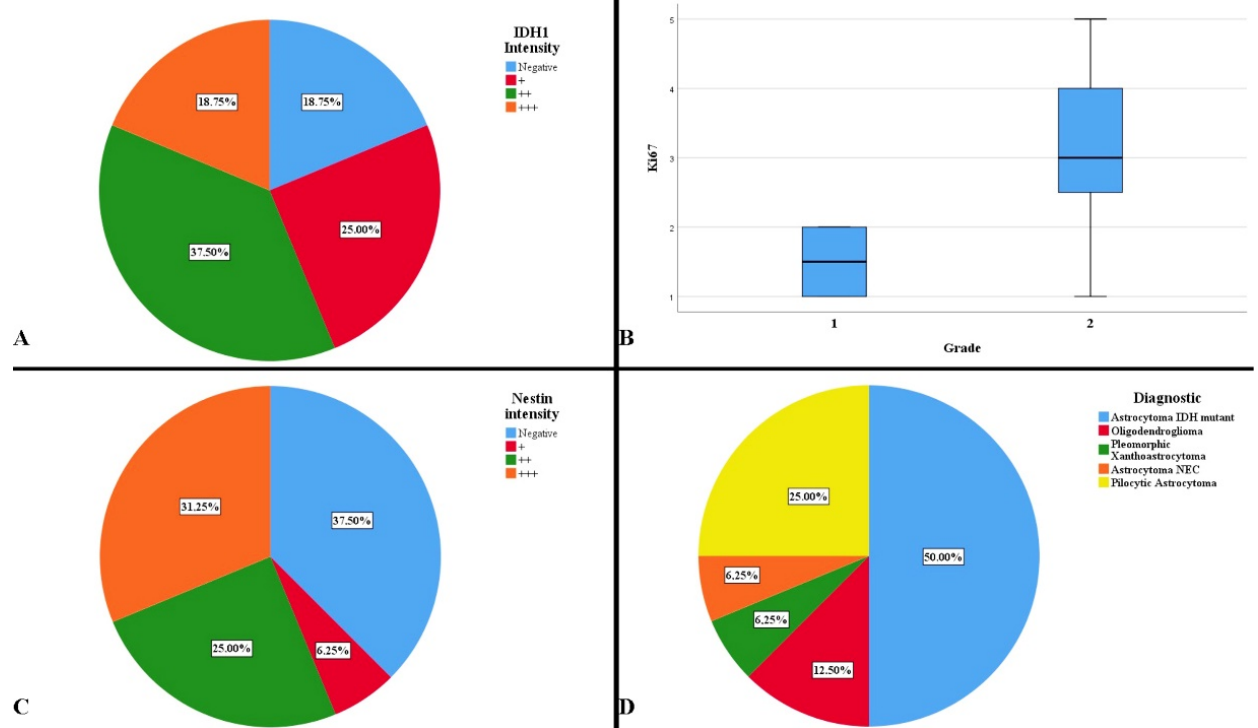
Figure 5. ( A ). Intensity of IDH1 immunoreaction. ( B ). Average distribution of Ki-67 proliferation Figure 5. ( A ) Intensity of IDH1 immunoreaction. ( B ) Average distribution of Ki-67 proliferation index index by histopathological degrees. ( C ). Intensity of Nestin immunoreaction. ( D ). Complete diag- by histopathological degrees. ( C ) Intensity of Nestin immunoreaction. ( D ) Complete diagnosis of the nosis of the studied cases. studied